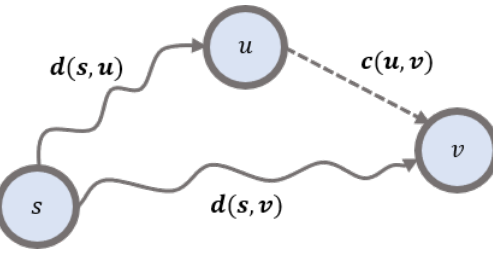
Figure 1. Principle of edge relaxation.